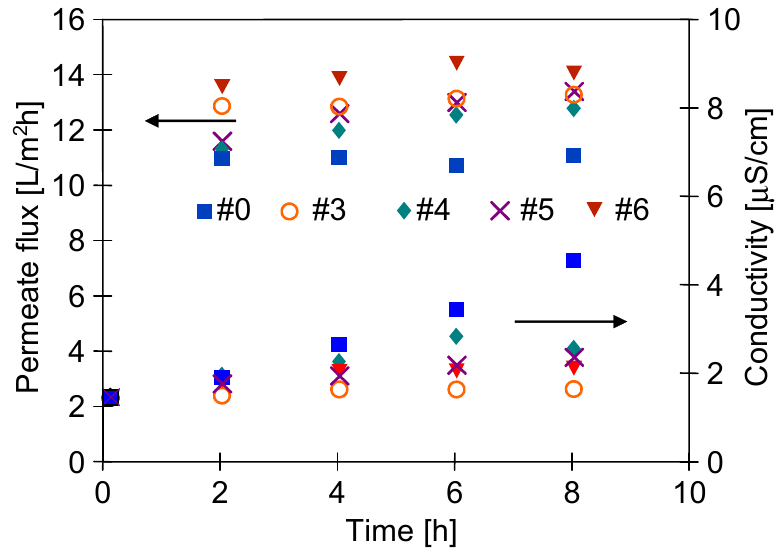
Figure 19. Changes in the permeate flux and distillate conductivity during MD process with the #0 membrane and plasma-treated membranes (#3–#6). Five years after plasma treatment.